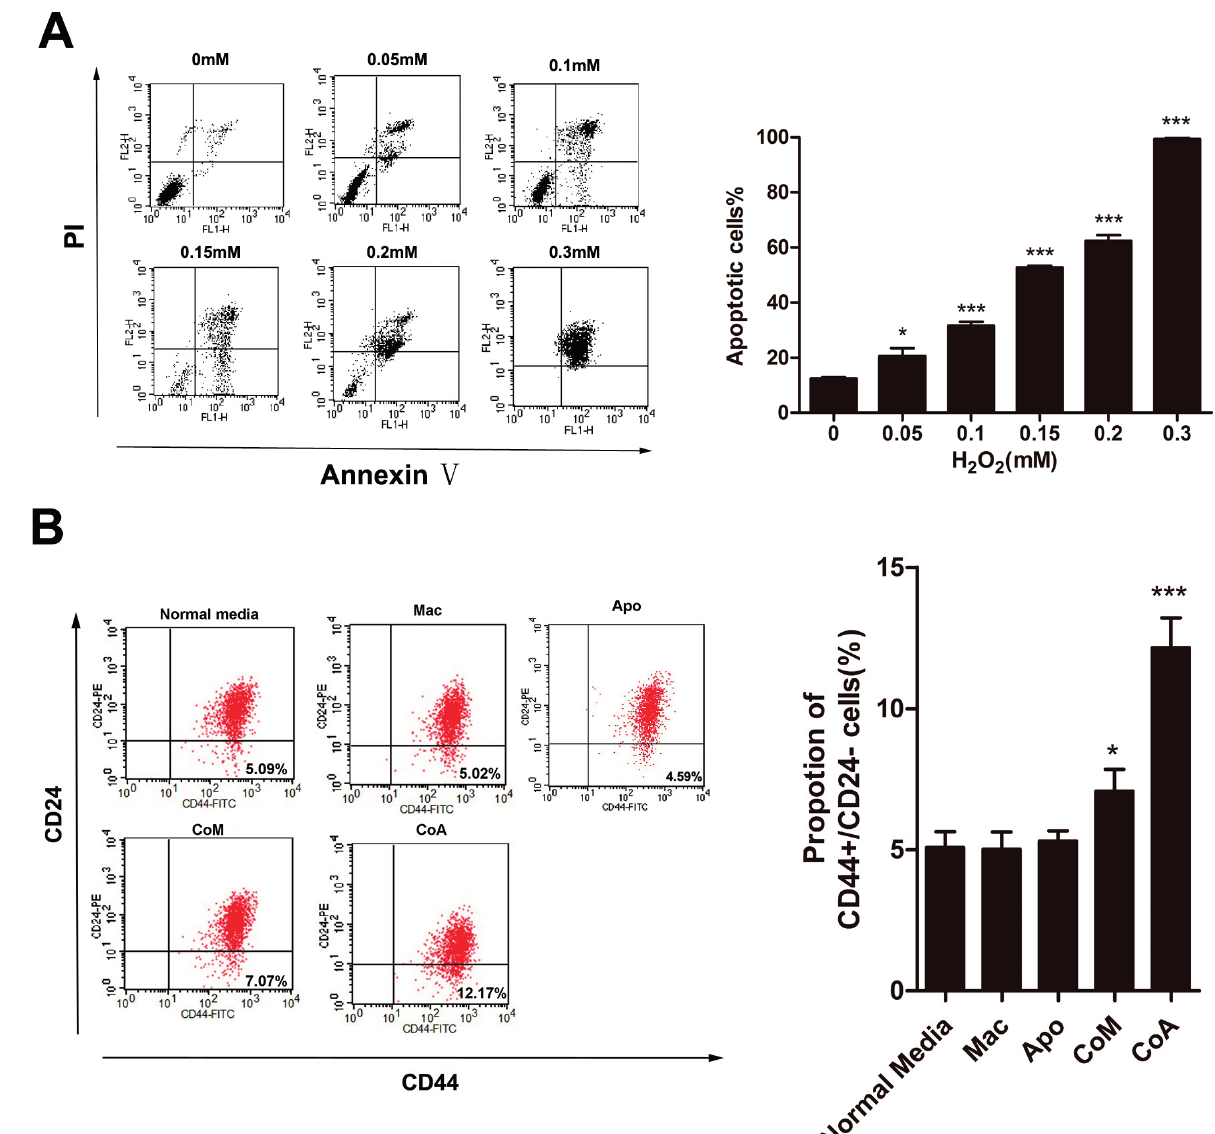
Figure 1. Analysis of CD44 + /CD24 − subpopulations in MCF-7 cells. ( A ) Analysis of the apoptotic effect of H 2 O 2 on MCF-7 cells. Percentage of apoptotic cells is the sum of the events in the upper right and lower right quadrants; ( B ) Flow cytometry analysis and quantification of the size of the CD44 + /CD24 − subpopulation of MCF-7 cells treated with different types of conditioned media. Results are typical of three independent